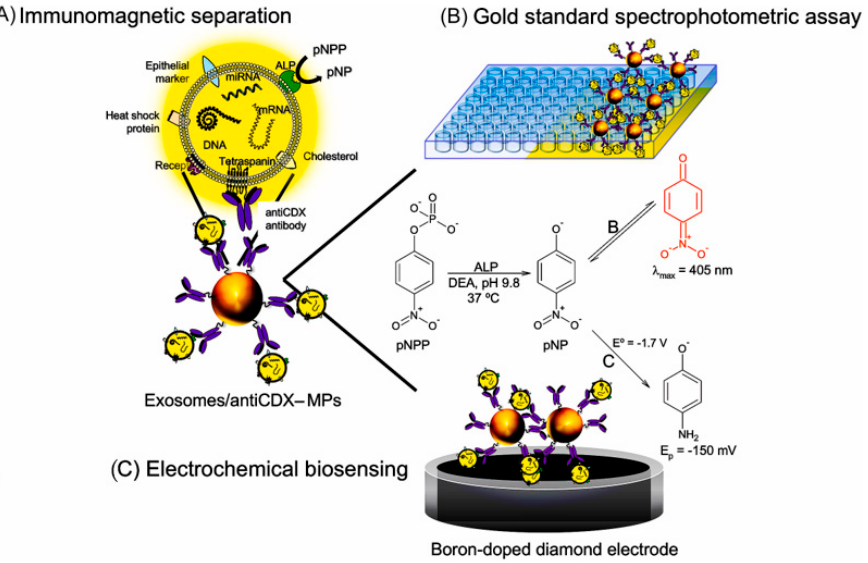
Figure 6. Different approaches for the detection of alkaline phosphatase (ALP) activity in osteoblast– derived exosomes by optical readout and electrochemical biosensor [28]. Copyright (2022)